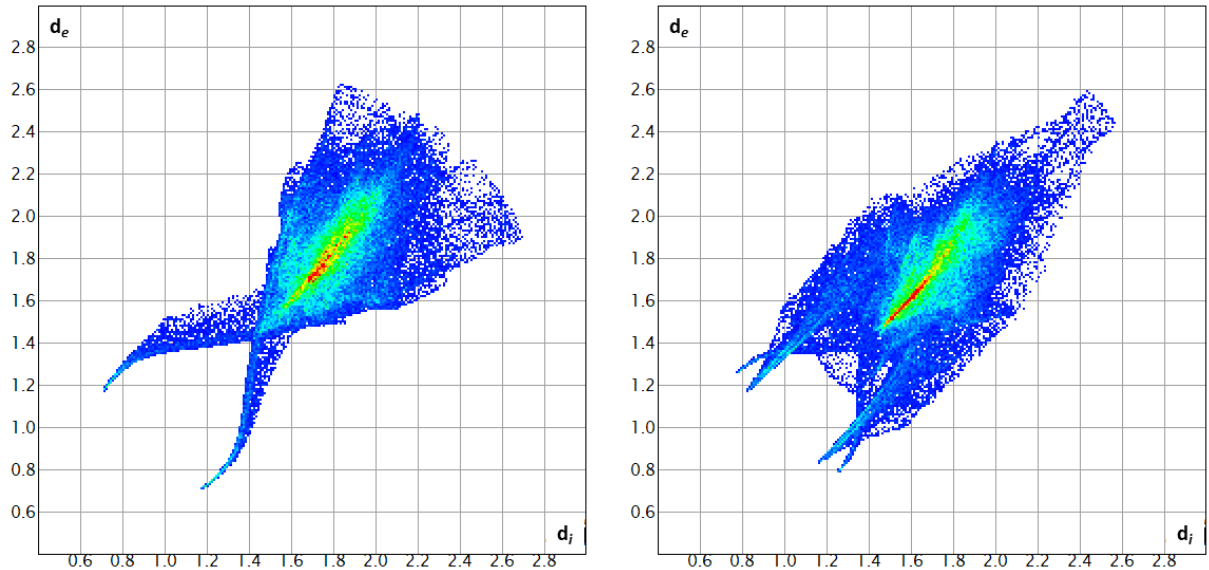
Figure 8. The fingerprint plots for [Li{BETI}] ( left ) and [Li{BETI}(H 2 O) 2 ] ( right ) . The total percentage of F···F interactions is higher in [Li{BETI}] (60.5%) than in [Li{BETI}(H 2 O) 2 ] (46.3%). This may seem to suggest that the F···F interactions are, in some way, favorable. However, this change in percentage is simply due to the positioning of the perfluoroethyl chain in [Li{BETI}(H 2 O) 2 ]. The cis orientation places atoms F1, F6,